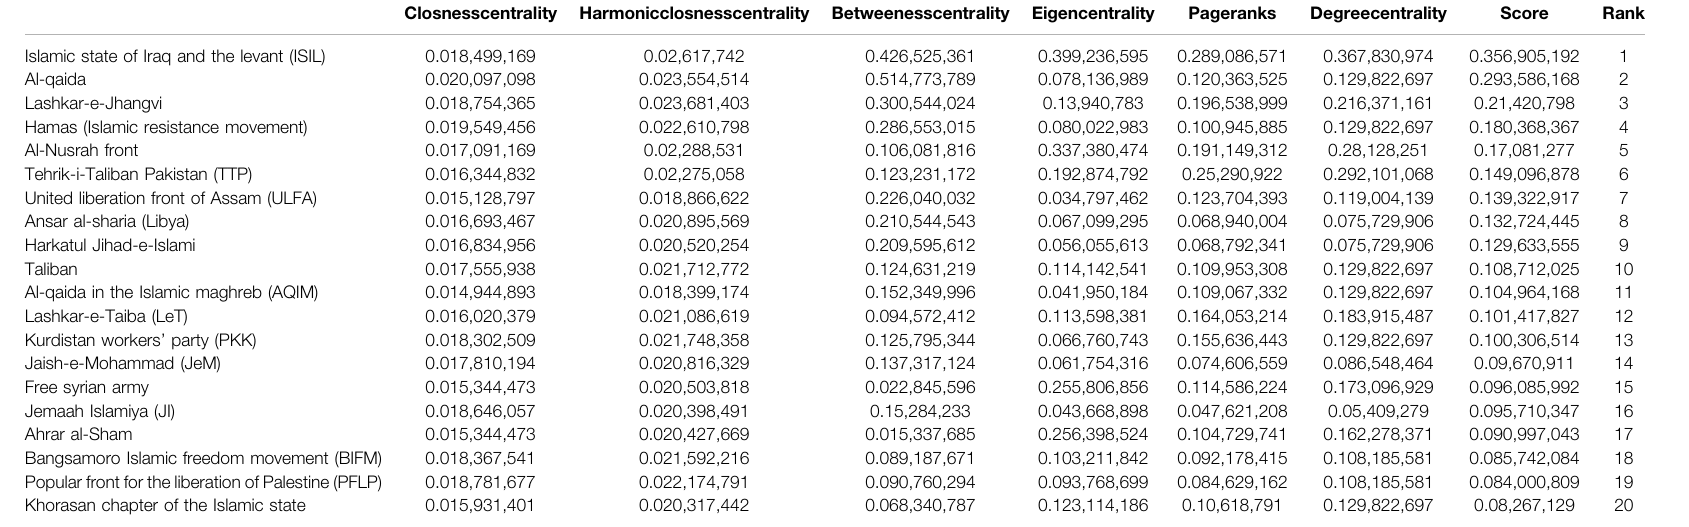
TABLE 3 | The top-20 ranked Terrorist Organizations.